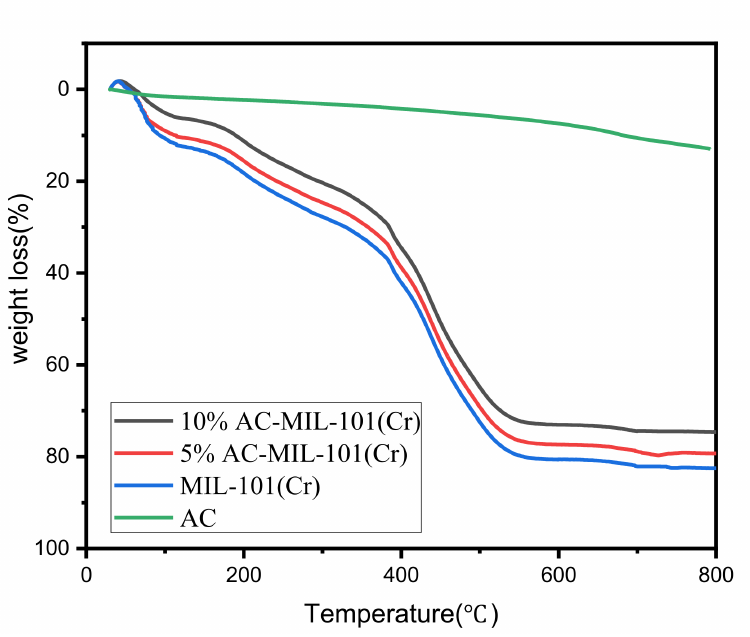
Figure 4. TG curves of the MIL-101(Cr) and the AC-MIL-101(Cr)